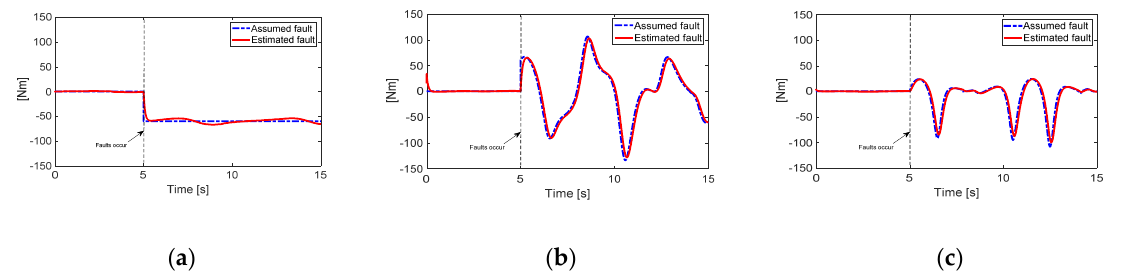
Figure 7. Fault estimation results in the simulation with multiple joint faults. ( a ) Joint 1; ( b ) Joint 2; ( c ) Joint 3.